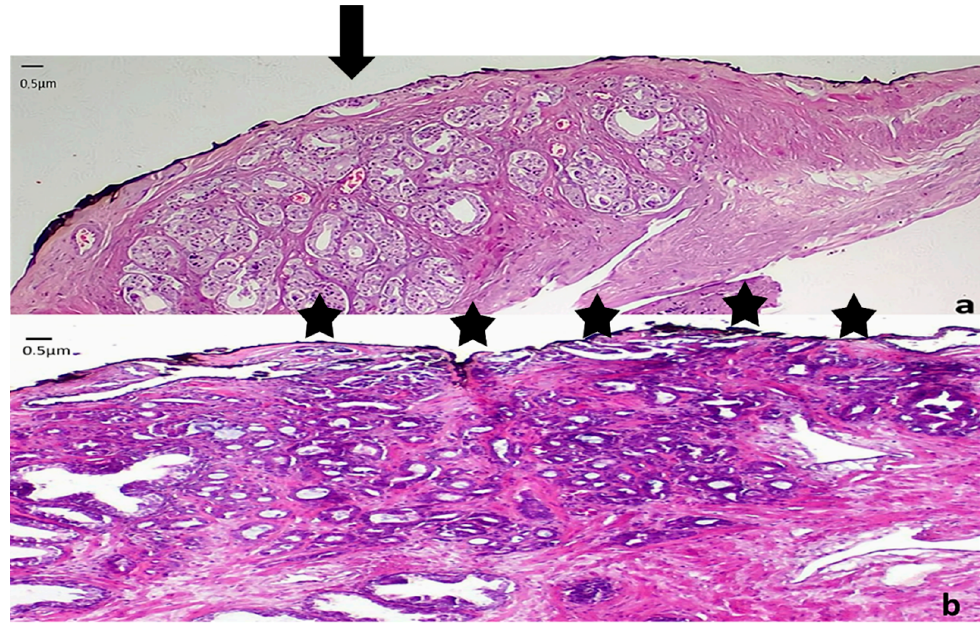
Figure 3. Representative images from low grade carcinomas with positive margins of different extent ( a ) Focal margin infiltration with neoplasm graded as PGG1. An arrow indicates the area of margin positivity (100 × magnification) ( b ) Nonfocal margin infiltration with neoplasm graded as PGG1. Five asterisks point the area of margin positivity. (40 ×